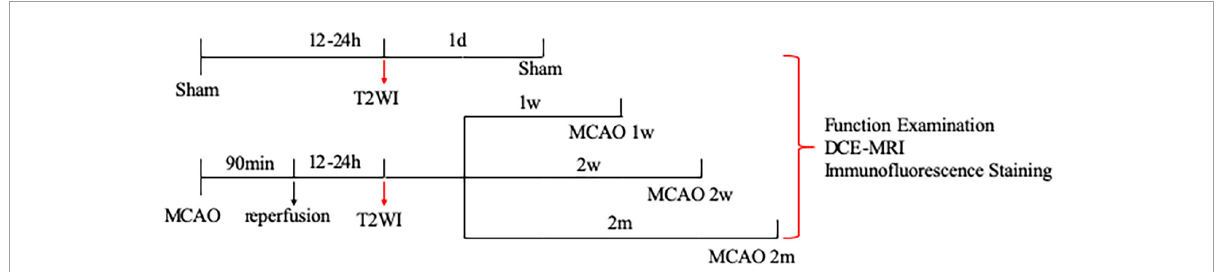
FIGURE1 Study design of the experiment. A total of 20 rats were randomly assigned into four groups: sham group ( n = 5), group of MCAO 1 week ( n = 5), group of MCAO 2 week (2w) ( n = 5), and group of MCAO 2 month (2m) ( n = 5). The ischemic severity was checked by T2-weighted MRI 12–24 h after the operation. Thereafter, all rats successively underwent neurological examination, DCE-MRI, and immunofluorescence staining. To be specific, neurological examination, DCE-MRI with intrathecal Gd-DTPA administration, and immunofluorescence staining were performed on the 1st day after the operation for the sham group, in the 1st week after the operation for the group of MCAO 1 week rats, in the 2nd week after the operation for the group of MCAO 2 week rats, as well as in the 2nd month after the operation for the group of MCAO 2 month rats. MCAO, middle cerebral artery occlusion; DCE-MRI, dynamic contrast-enhanced MRI; Gd-DTPA, gadolinium-diethylenetriaminepentaacetic acid.